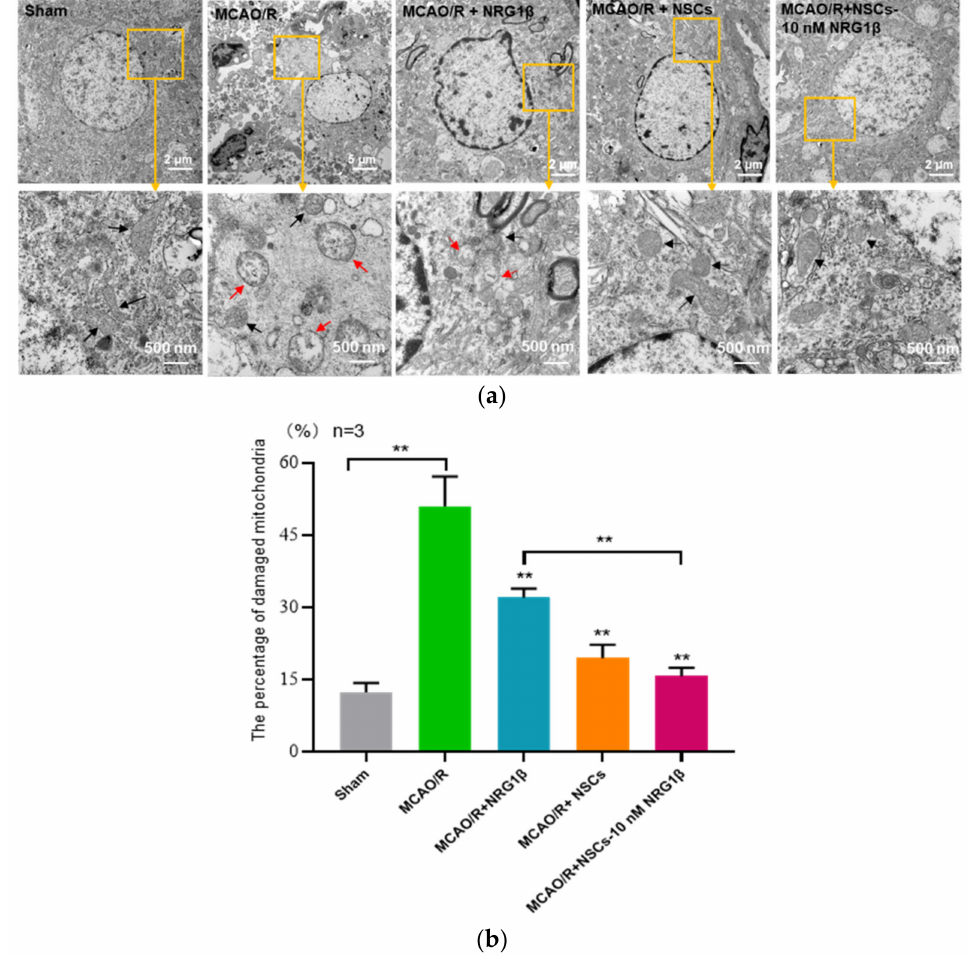
Figure 4. Effect of NSCs transplantation on mitochondrial injury in ischemic cortical region. ( a ) Rep- resentative pictures of neuron mitochondrial morphological structure in each group; red arrows indicate damaged mitochondria, and black arrows indicate normal mitochondria. ( b ) Percentage of damaged mitochondria. ** p <